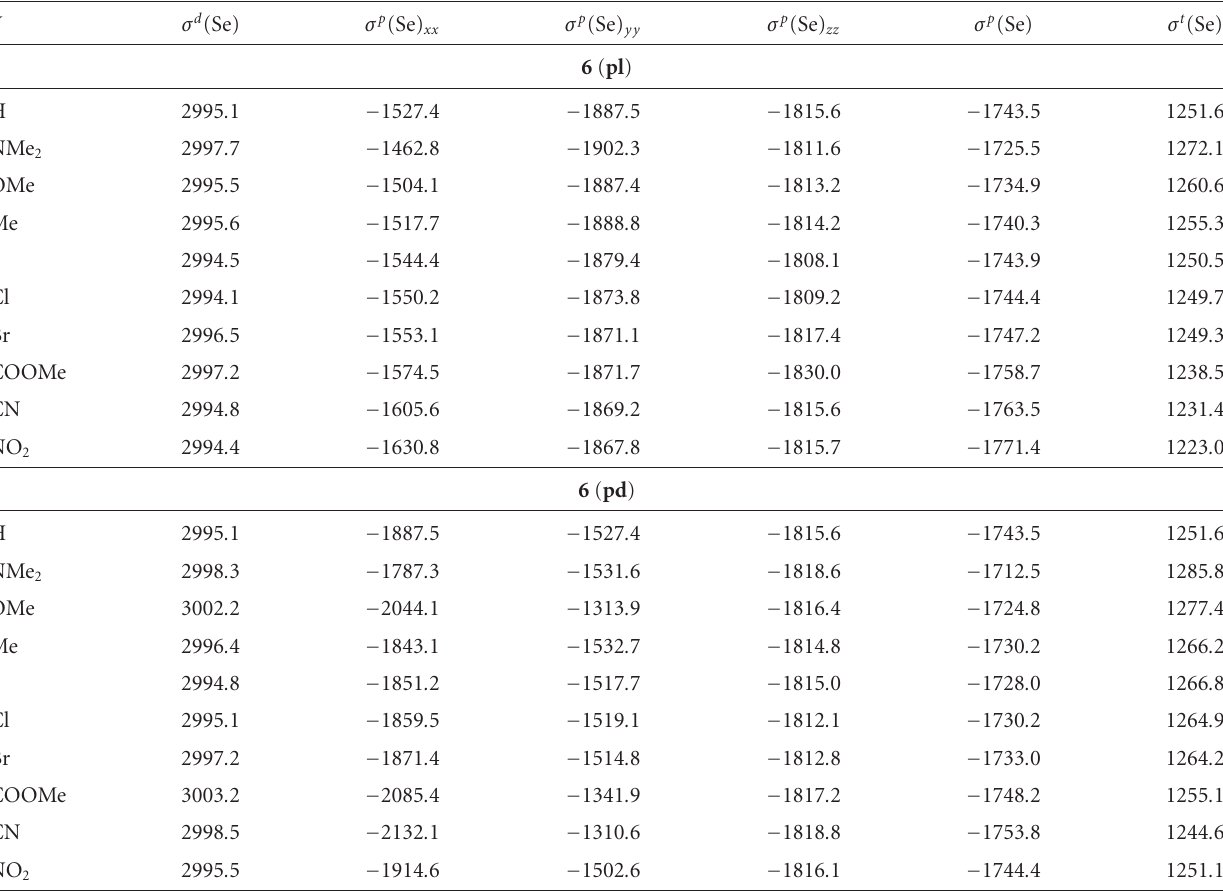
Table 5: Calculated absolute shielding tensors ( σ (Se)) of 6 , containing various Y (a) .